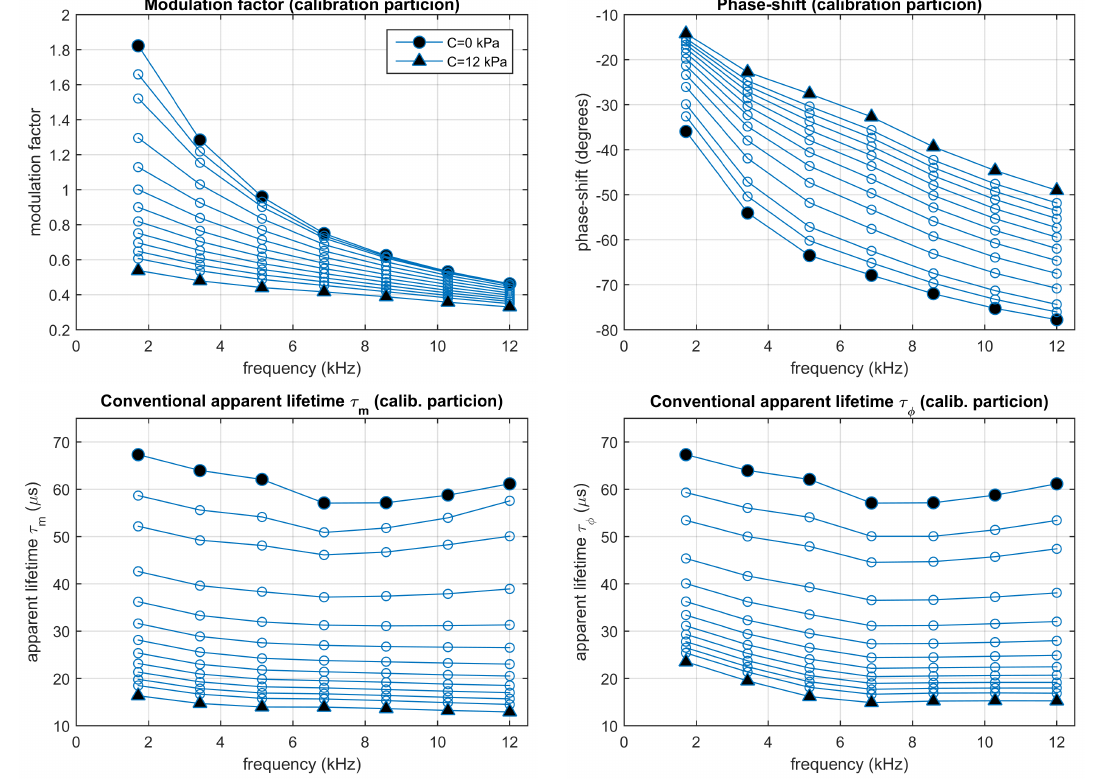
Figure 8. Experimental results: Conventional modulation factor and phase-shift ( top panels ) and the corresponding apparent lifetimes ( bottom panels ). Average values measured from the calibration partition. Each point corresponds to one harmonic (from 1st to 7th) and oxygen concentration (0, 0.5, 1, 2, 3, 4, 5, 6, 7, 8, 9, 10, and 12 kPa pO 2